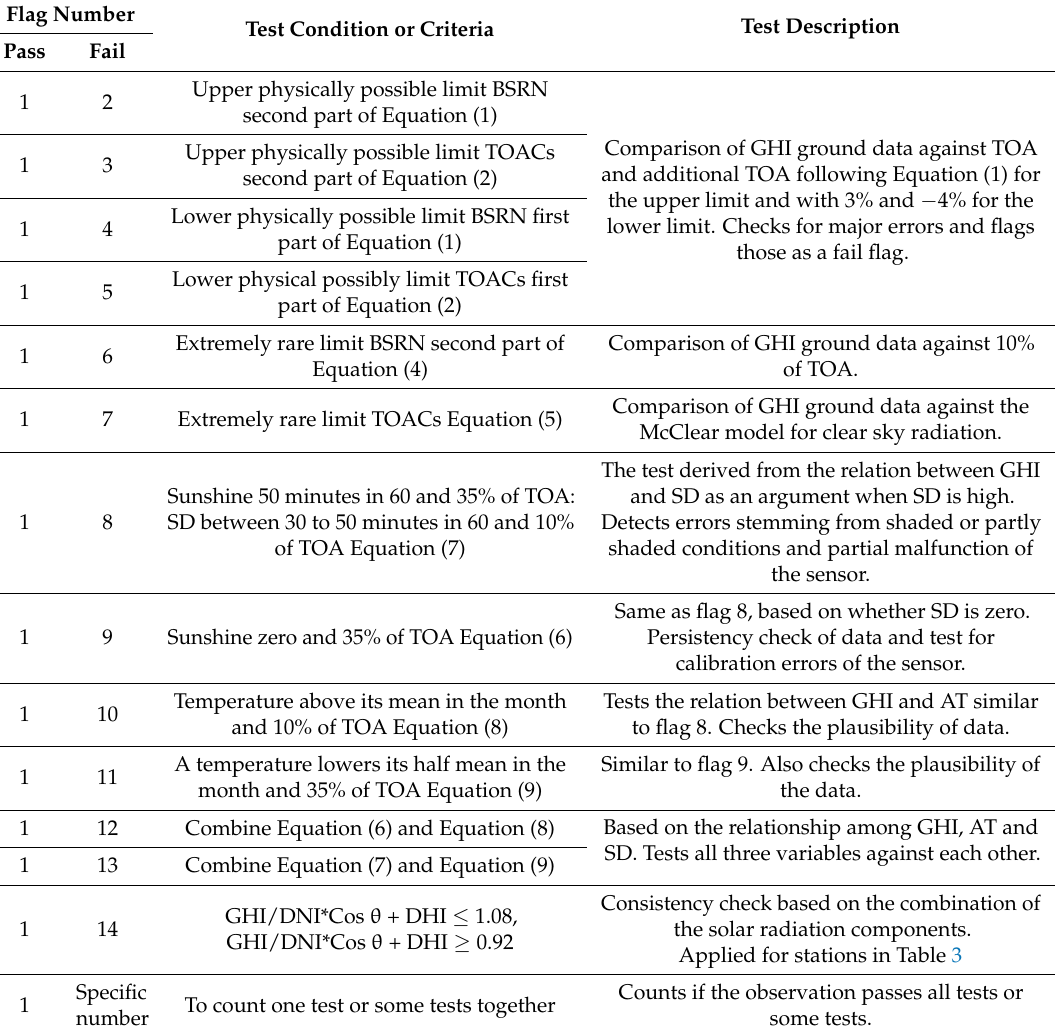
Table 4. Flag number and description of quality control